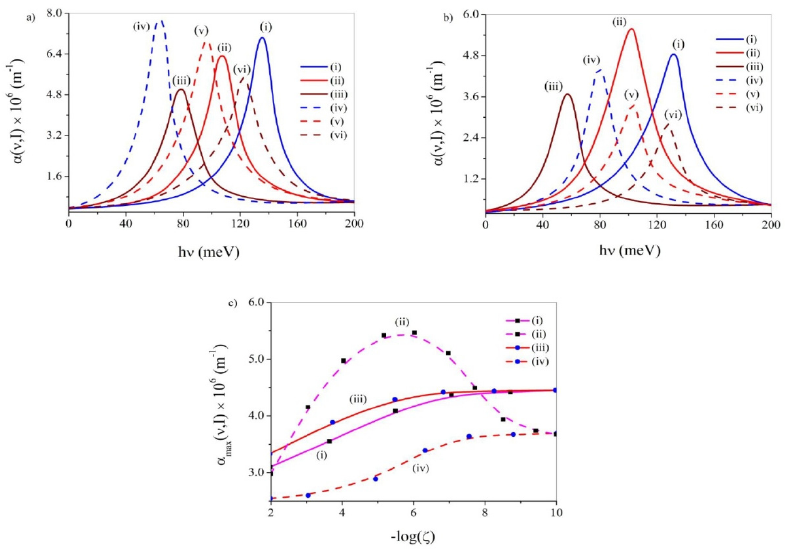
Figure 2. TOAC vs. h υ diagrams with ( a ) OPA and ( b ) EPA. In these diagrams (i) ADWN and ζ = 10 − 10 , (ii) ADWN and ζ = 10 − 6 , (iii) ADWN and ζ = 10 − 2 , (iv) MLWN and ζ = 10 − 10 , (v) MLWN and ζ = 10 − 6 , (vi) MLWN and ζ = 10 − 2 . ( c ) Depiction of TOAC peak heights vs. − log( ζ ): (i) with ADWN and OPA, (ii) with ADWN and EPA, (iii) with MLWN and OPA and (iv) with MLWN and